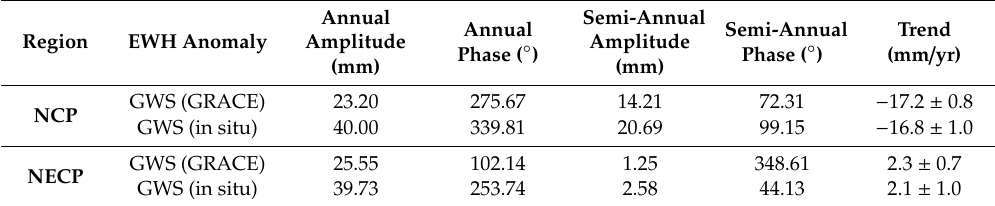
Figure 7. The groundwater storage anomaly (GWSA) from GRACE and in situ well observations, and monthly precipitation in the NCP ( a ) and NECP ( c ) during the period of 2003–2016. The grey shading is the error of the GRACE-derived GWSA. Annual precipitation and mean annual precipitation in the NCP ( b ) and NECP ( d ) from 2003 to 2016. Table 2. The annual amplitude and phase, semiannual amplitude and phase, and the trend in equivalent water height (EWH) anomalies in GRACE-derived GWS